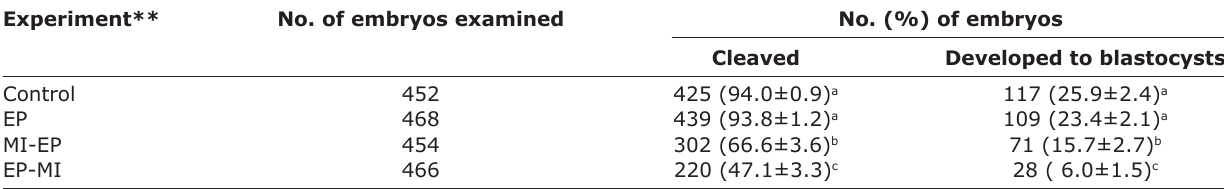
Table-2: Effects of EP alone or in combination with MI on the development of porcine zygotes*.